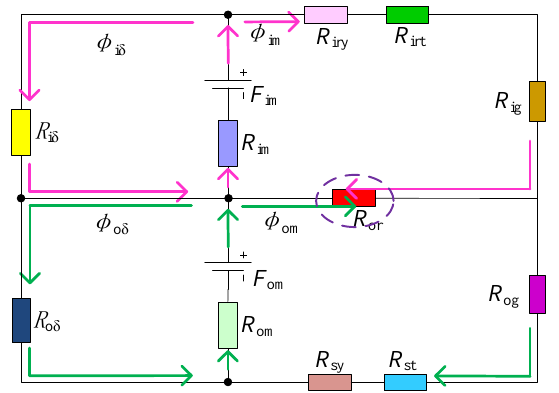
Figure 7. No-load equivalent magnetic circuit in consistent magnetization direction.